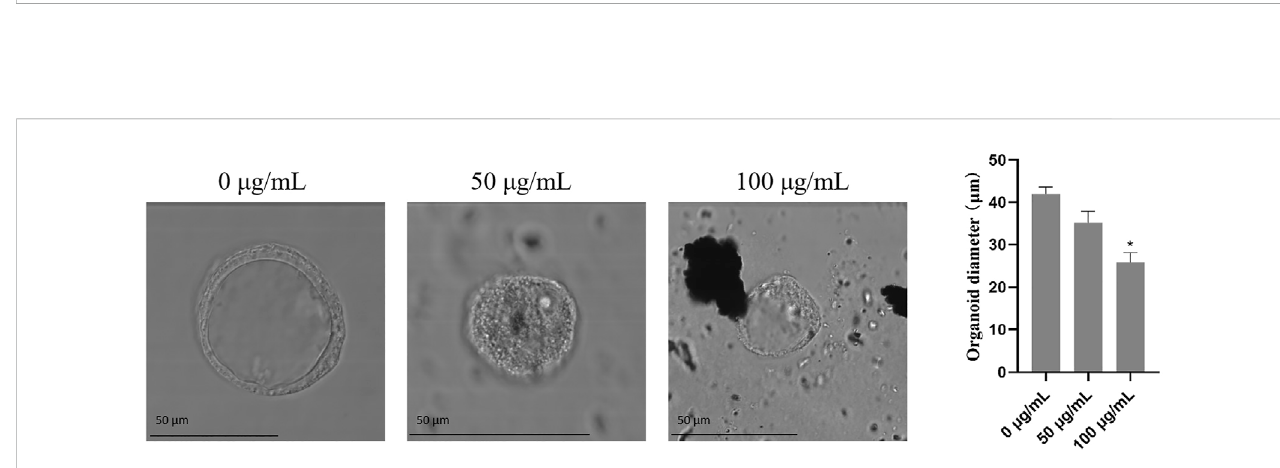
FIGURE 5 Effects ofTWPson thegrowth ofhAOs. ThemorphologyofhAOs wascapturedunderbright fi eldtodeterminethediametersofhAOs; scale bar,50 μ m.